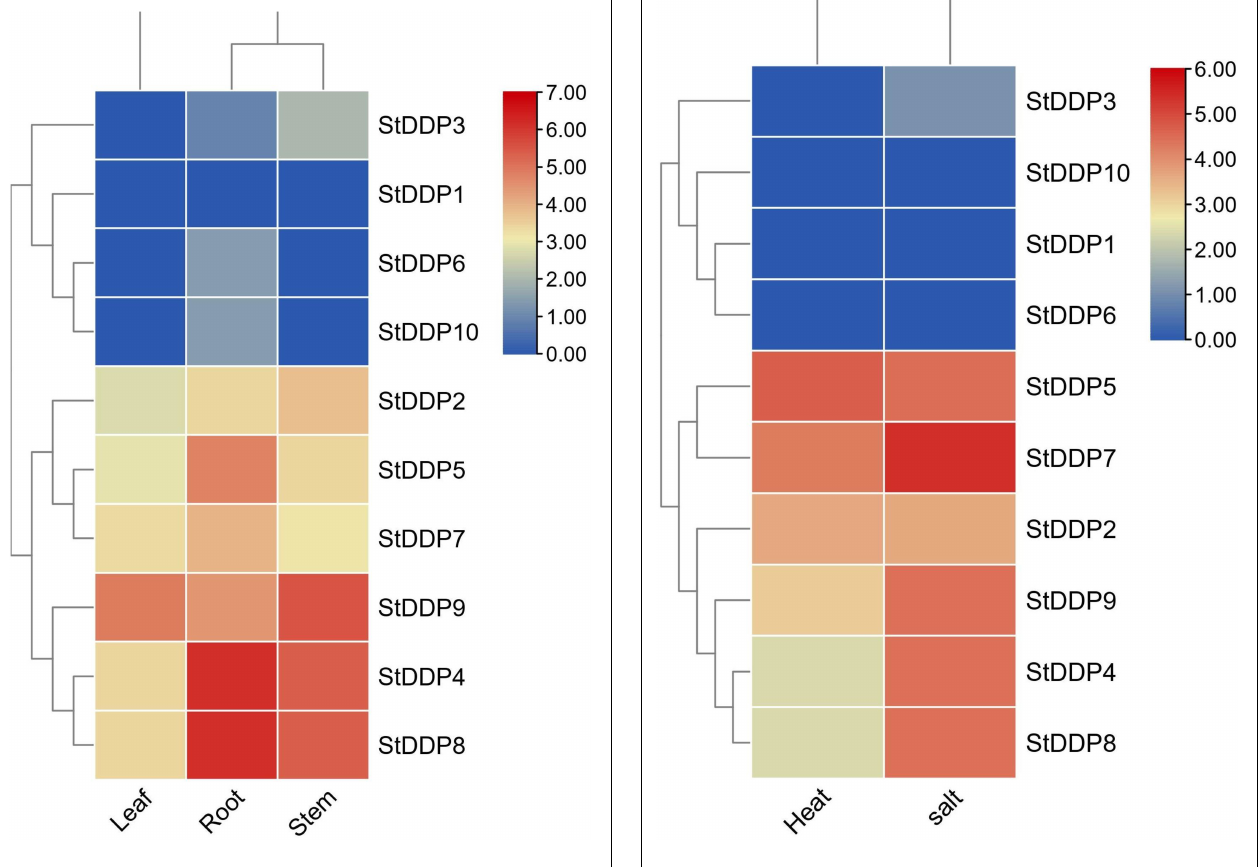
FIGURE 7 | Expression profiling of StDDP genes in leaves, roots, and stems. FIGURE 8 | Expression profiling of StDDP genes in response to heat and